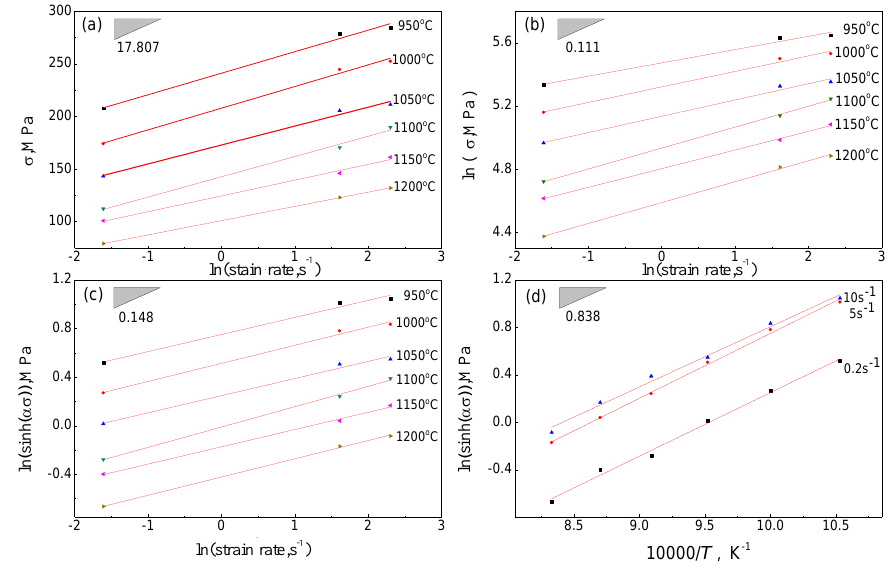
. . . ε ; ( b ) ln σ against ln ε ; ( c ) lnsinh( ασ ) against ln ε ; and